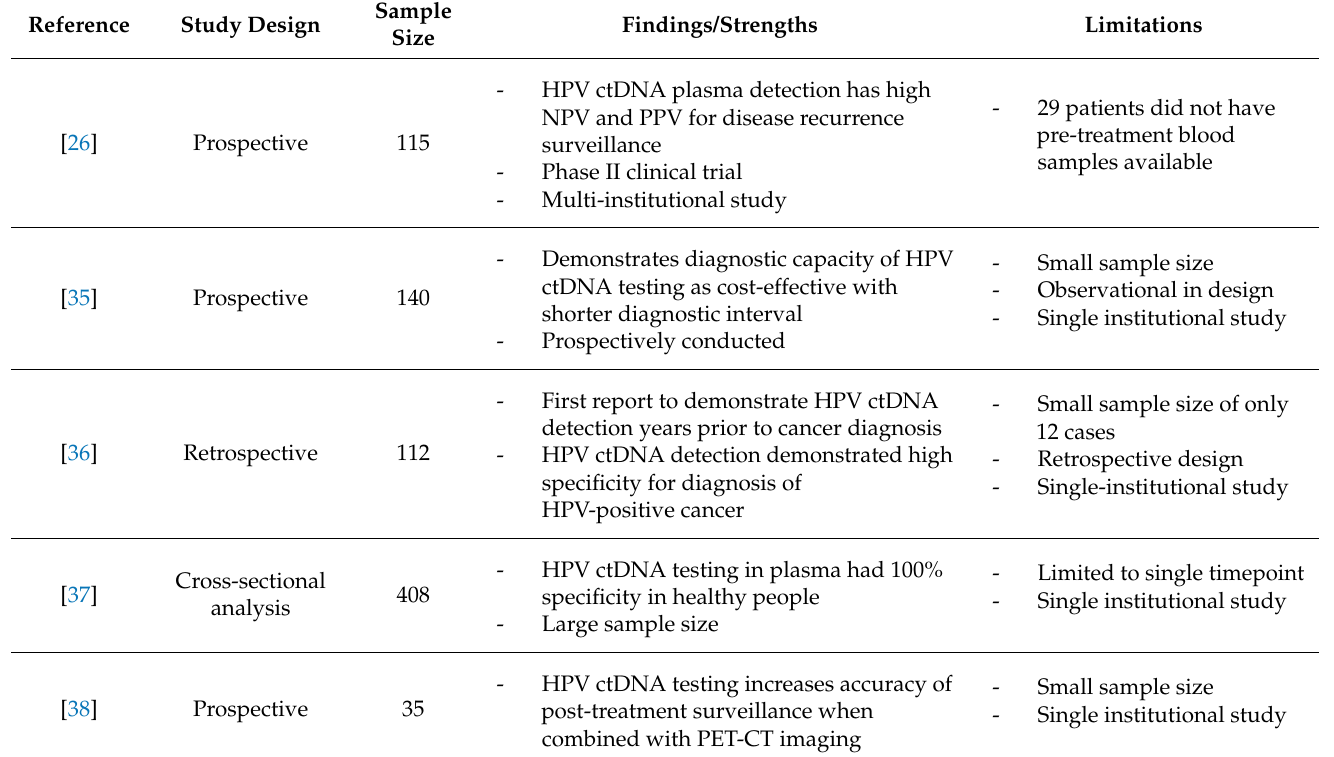
Table 1. Key studies examining HPV ctDNA as a biomarker for HPV-positive